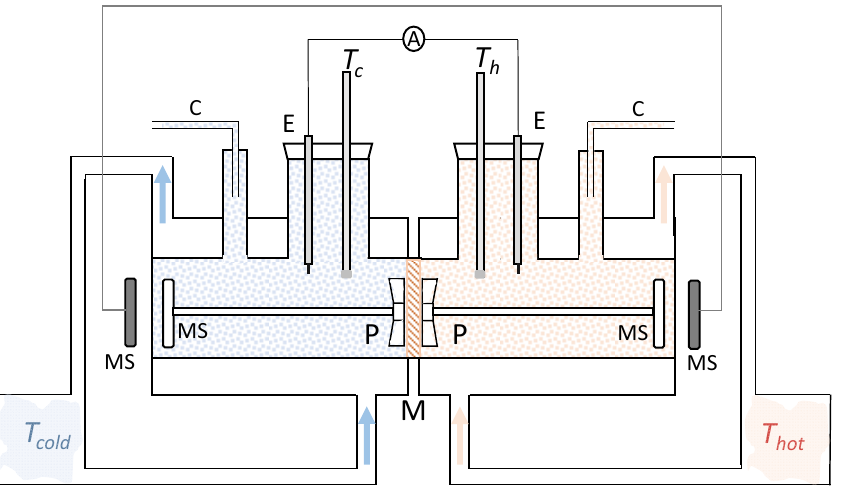
Figure 3. Sketch of the experimental device used in this work. M: Ion-exchange membrane; P: Pro- peller, MS: Magnetic stirrer; C: Capillary; E: Ag|AgCl electrode; T i : Platinum resistance thermometer; A: Amperemeter.